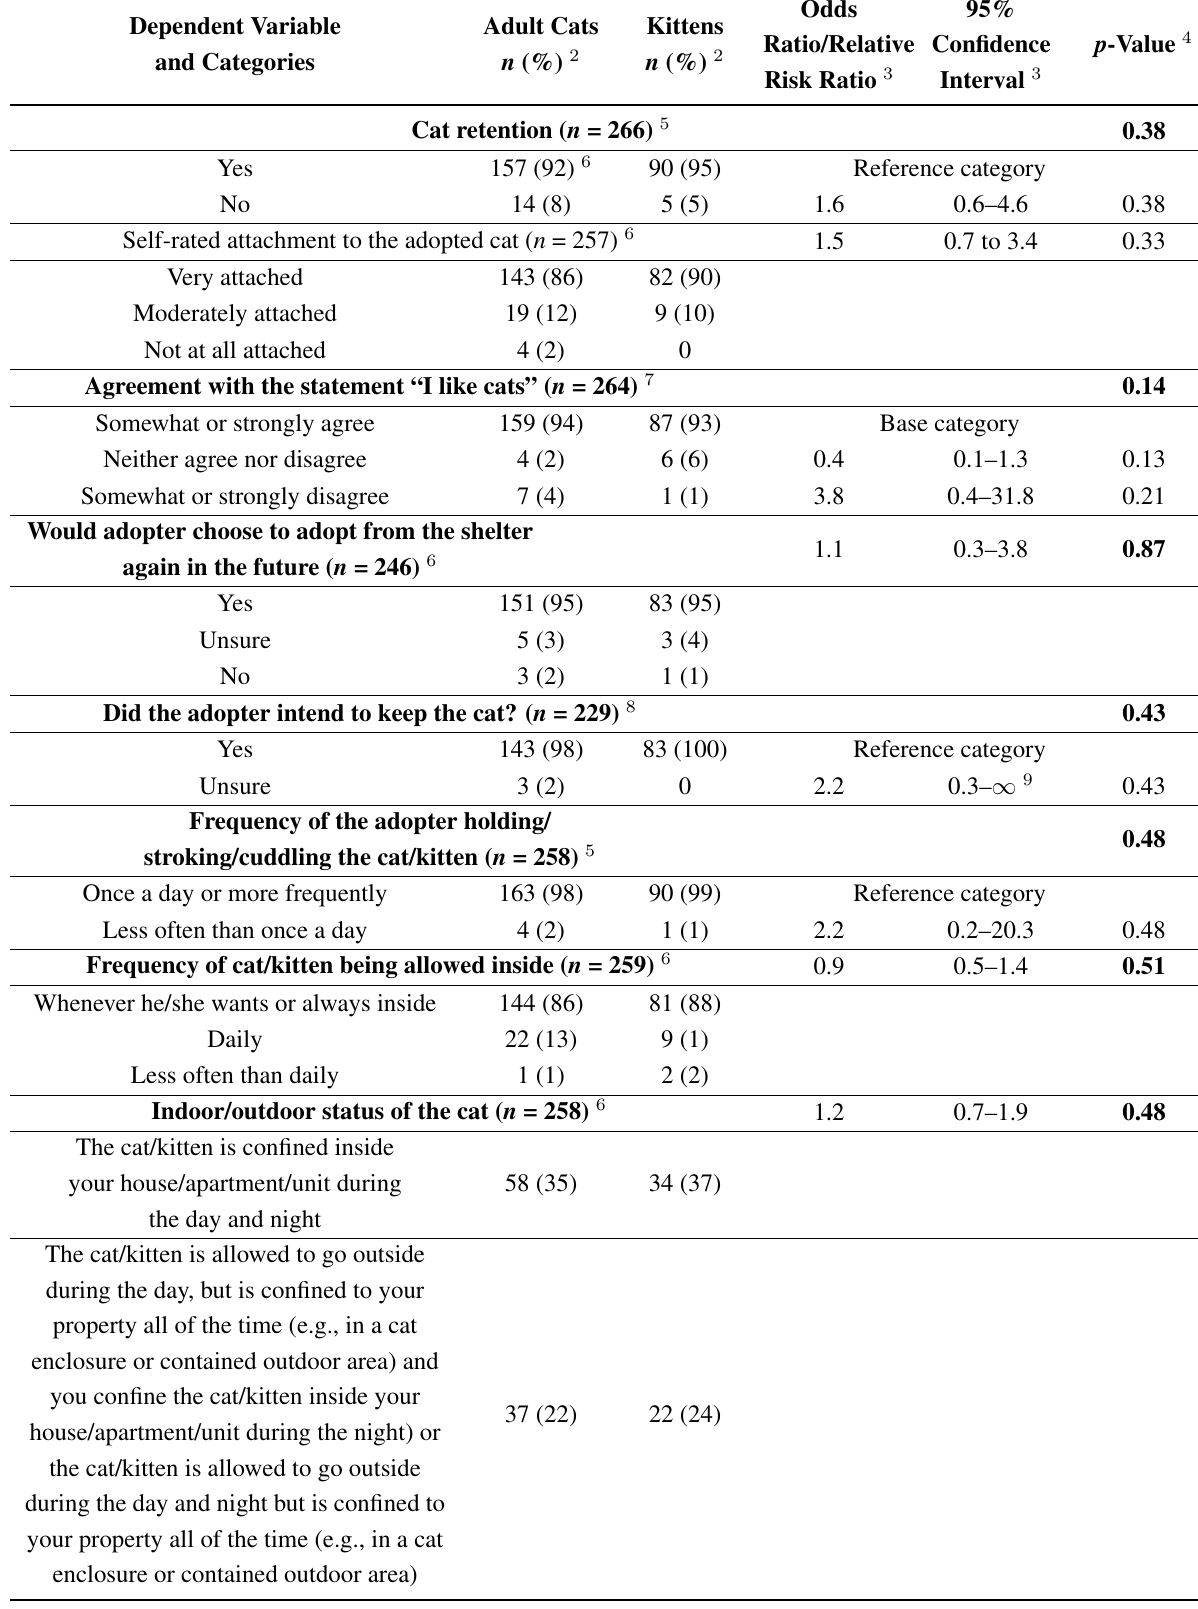
Table S4. Distributions of adoption outcomes by type of cat adopted (adult cat or kitten) for 266 cats adopted from an animal shelter in Australia in 2013 for variables with p -values ≥ 0.05 on univariable analyses comparing distributions between cat age